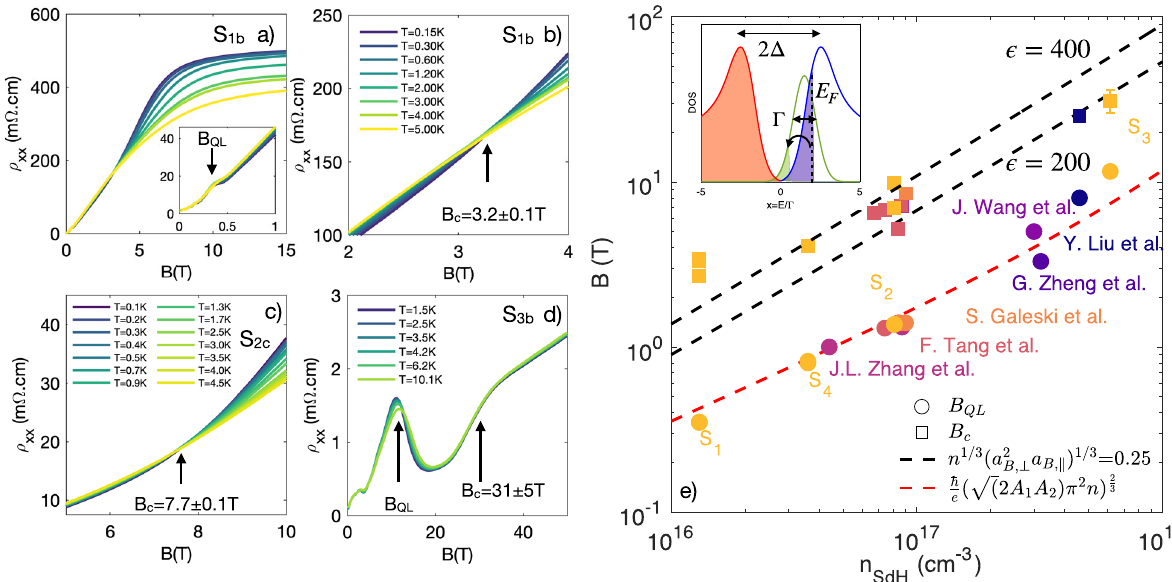
Fig. 2 Doping evolution of the transition detected in the ultra-quantum regime of ZrTe 5 for B ∥ b. a ρ xx vs magnetic fi eld for samples S 1 b . Inset: same as a) up to 1 T. b Same as a with a zoom on the crossing point in ρ xx . c , d Same as a for samples S 2 c ad S 3 b . At low doping the onset of the transition is marked by a crossing point. At the highest doping it evolves into a step in ρ xx . The width of the step has been taken as the error bar of B c . e Doping evolution of the position of the last quantum oscillation, B QL (yellow closed circles) and the onset of the transition, B c (yellow closed squares) as determined in ρ xx which agrees well with results from the literature 18,22,24,35,52,53 . The dashed red line in Fig. 2e is the value of B QL for an anisotropic ellipsoid (see text). The dashed black lines are the onset of the magnetic freeze-out transition according to Eq. (1) with ϵ = 200 and 400. Inset : sketch of the density of state of n-type ZrTe 5 for B > B c : the (0, − ) Landau level of the conduction and valence band are plotted in blue and red while the shallow band is in green. The broadened density of states ( Γ ) derived from 43 . The freez-out transition in ZrTe 5 occurs in the peculiar regime where Γ ≈ Δ ≈ E F